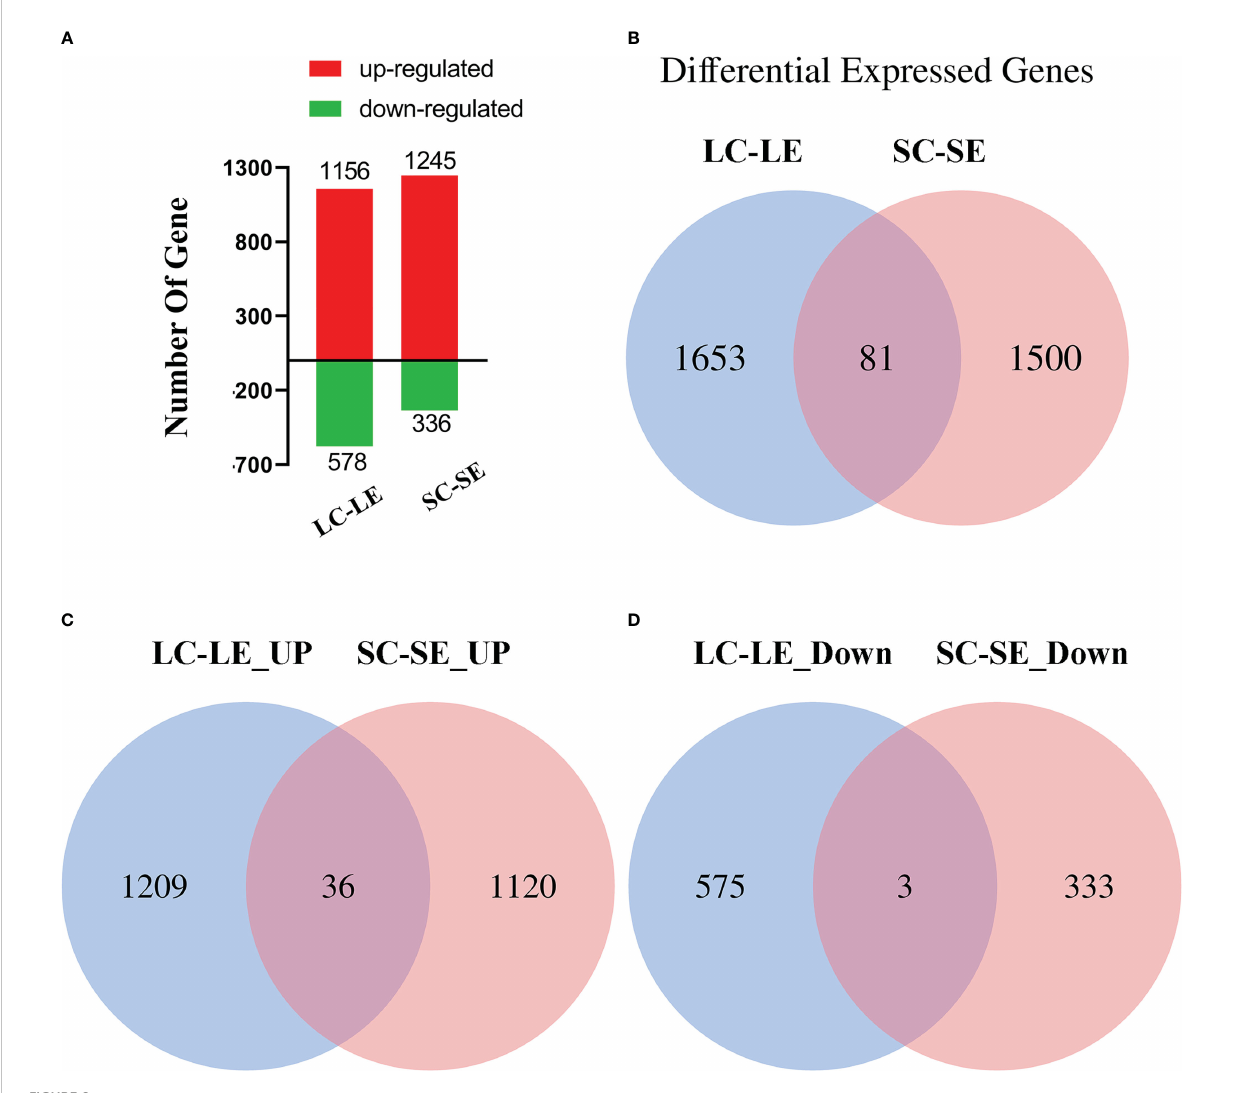
FIGURE 2 Statistical results of different expressed genes (DEGs). (A) The number of the differentially expressed genes in workers, LC-LE and SC-SE. Red bar for up-regulated genes, green bar for down-regulated genes. (B) Venn diagram shows 2-fold expression of transcripts in the LC-LE and SC-SE transcriptome. (C) Venn diagram shows the up-regulated expression of transcripts in the LC-LE and SC-SE transcriptome. (D) Venn diagram shows the down-regulated expression of transcripts in the LC-LE and SC-SE transcriptome. Statistical analysis results were all Padj <